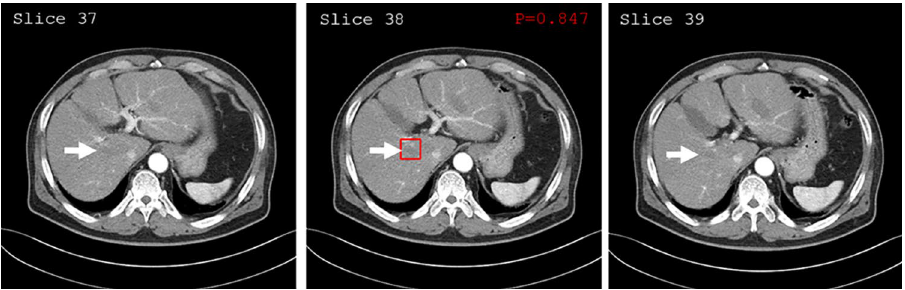
Figure 3. Prediction map for false-positive-predicted LTP region. LTP was detected (red rectangular) on the prediction map. However, we discovered that the detected region was far from the ablation zone. The unenhanced right hepatic vein (arrows), next to the contrast-enhanced hepatic vessels, was regarded as an ablation zone from artificial